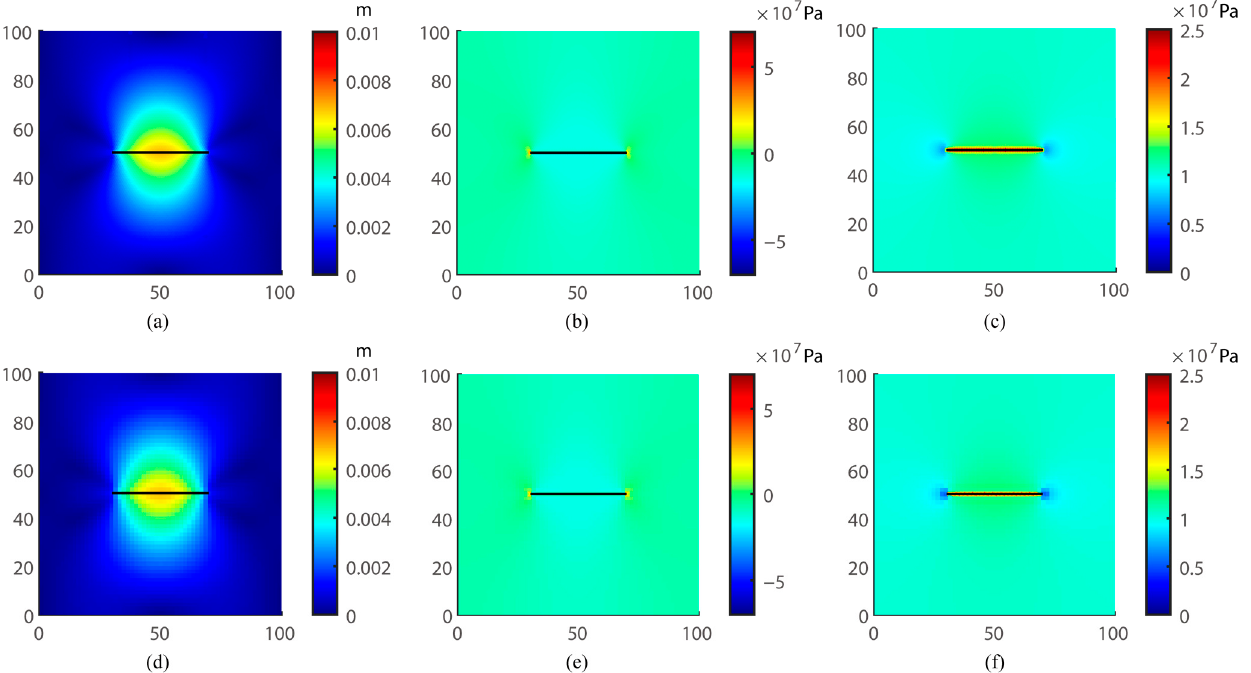
′ y and pressure at 1000 s , ′ y distribution ′ y distribution calculated by UXFEM,